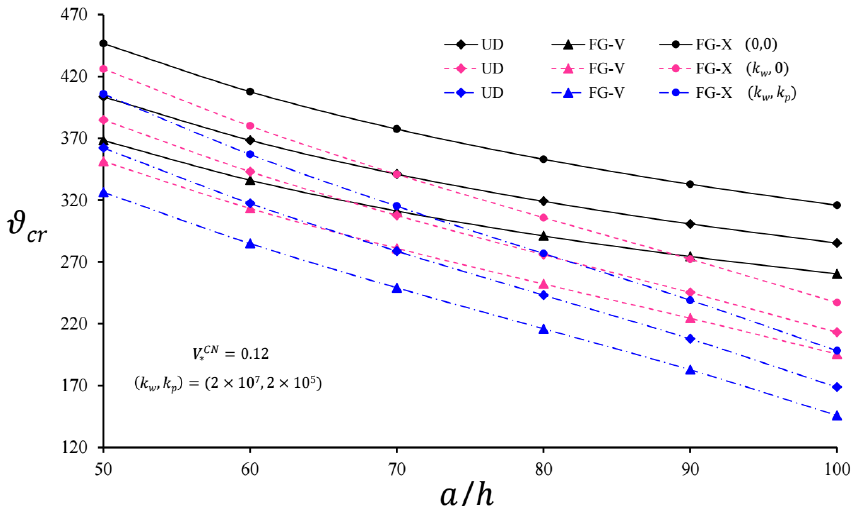
Figure 3. Variation in the critical velocity of infinite length CNT-based cylindrical pipes with and without EFs versus the a / h for V CN ∗ = 0.12. Table 5. Variation in the dynamic coefficients of infinite length CNT-based cylindrical pipes versus the k w and k p ( ϑ = 300 m/s, a = 30